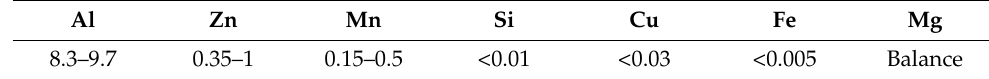
Table 1. Chemical composition of the base metal